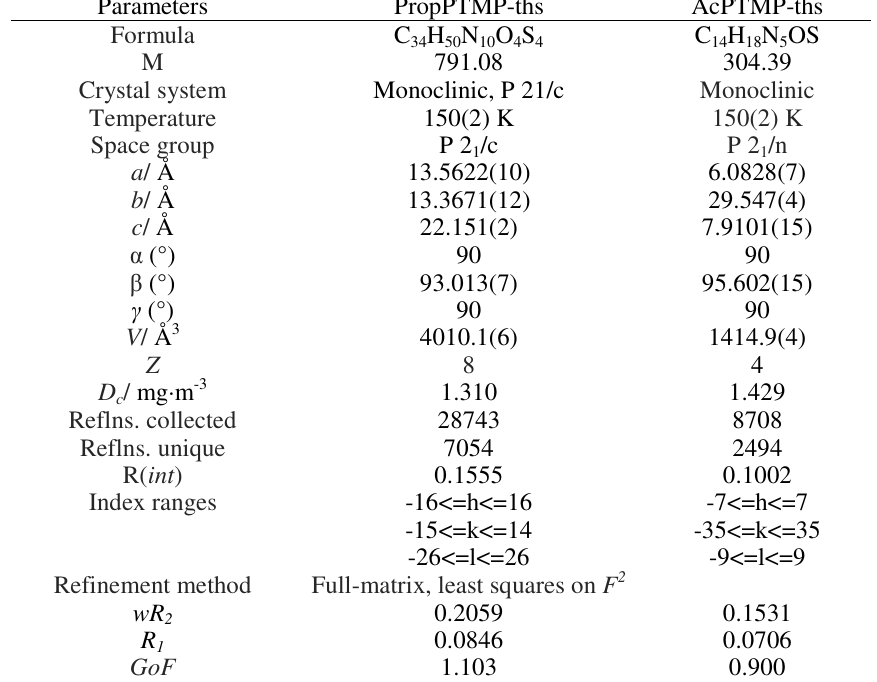
Table 1. Summary of crystallographic data for compounds PropPTMP-ths & AcPTMP-ths Parameters